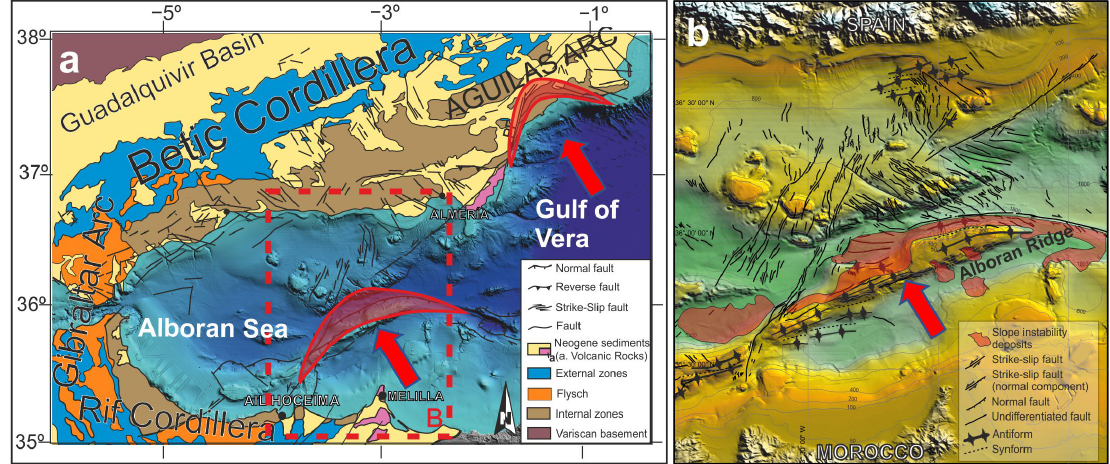
Figure 9. Example of multiple geological hazards in a tectonic indentation area in the western Mediterranean: ( a ) Geologic map showing the main tectonic features of the westernmost Mediterranean and the tectonic indentation zones in the central Alboran and Aguilas Arc in the Gulf of Vera; ( b ) detailed tectonic features of the Central Alboran Basin (for more details see [195]) and areas of generalized slope instability deposits (red areas). Legend: the red arrow indicates the direction of tectonic indentation and the red shading indicates the location of tectonic indentation.